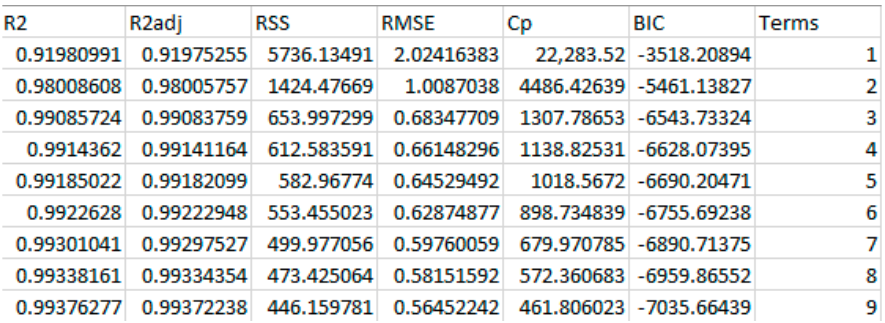
Figure 8. Information criteria for best models.